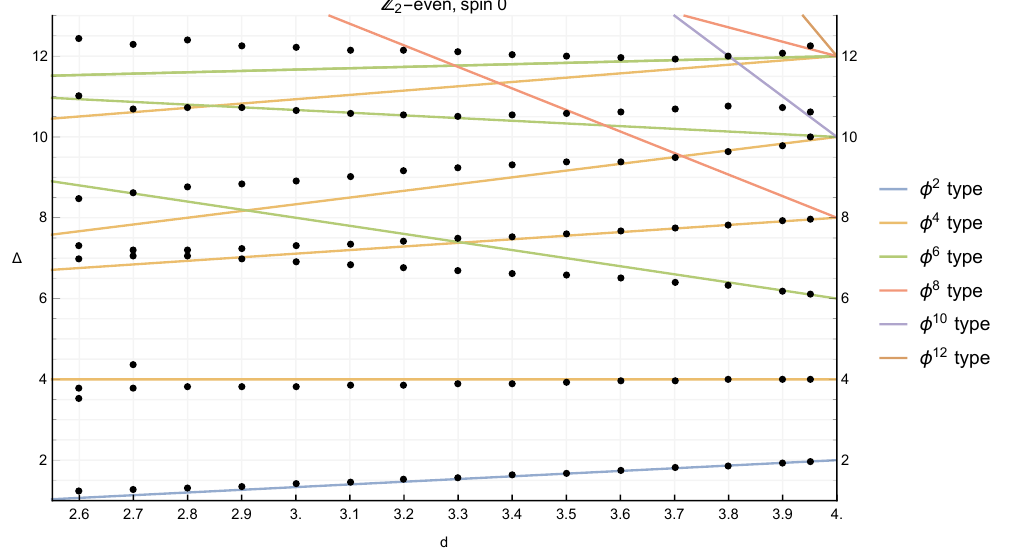
Figure 2 . The dimensions of the Z 2 -even operators of spin 0. The black dots indicate the spectrum found using the EFM at the navigator minimum. The lines of various colors denote the leading order ε -expansion prediction for operators of a certain type (see the main text).